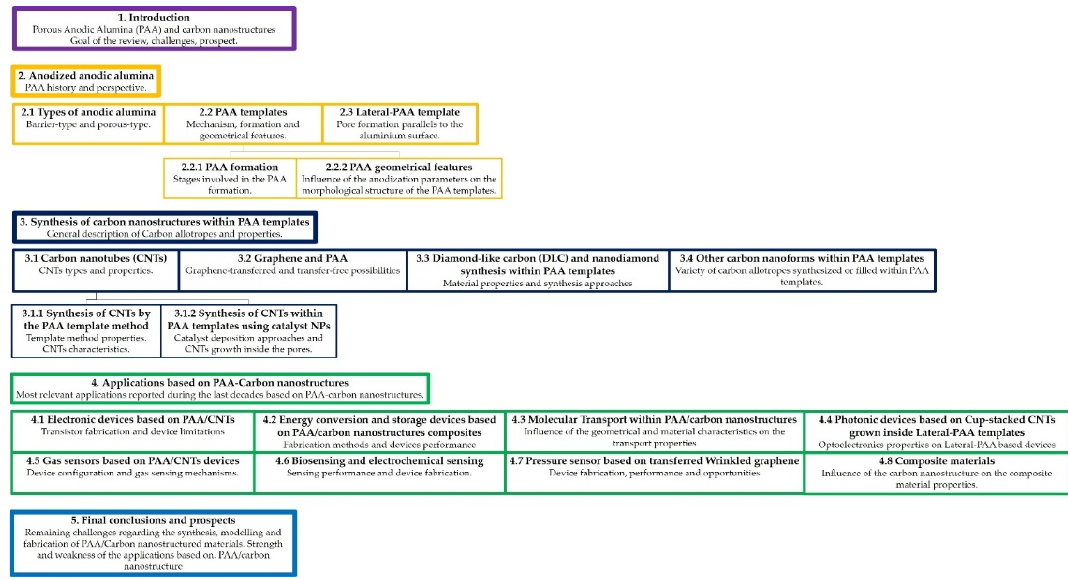
Figure 2. Structure diagram of the present review article.